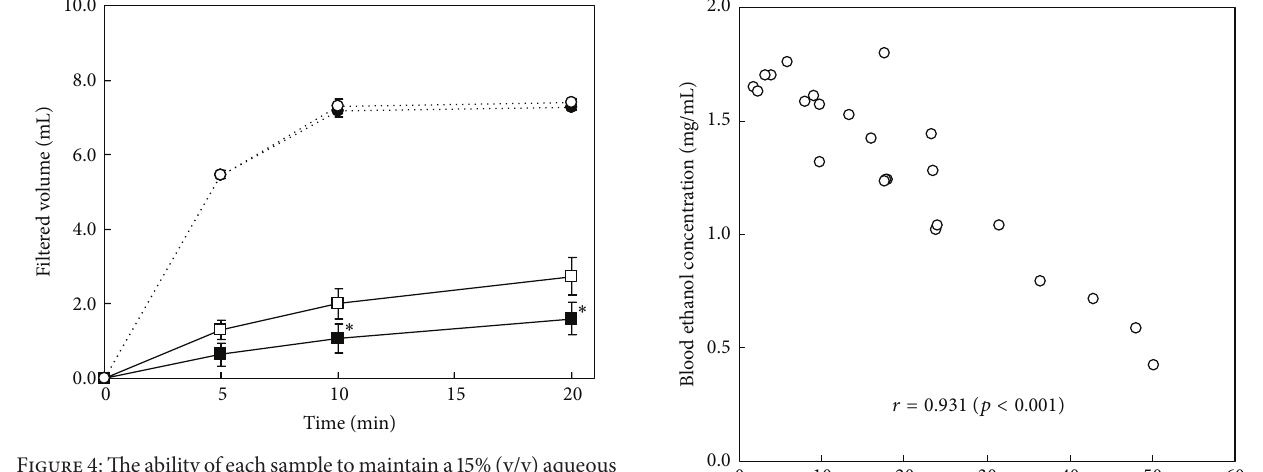
Figure 4: The ability of each sample to maintain a 15% (v/v) aqueous ethanol solution. Results are expressed as mean and standard deviation ( 𝑛 = 3 ). Asterisks indicate significant differences from the water-insoluble fraction (WIF) suspension group; 𝑝 < 0.05 , Student’s 𝑡 -test. --- e ---, control group; --- I ---, 5.0% aqueous alanine solution group; — ◻ —, 0.5% WIF suspension group; — ◼ —, 0.5% WIF + 5.0% alanine suspension group.